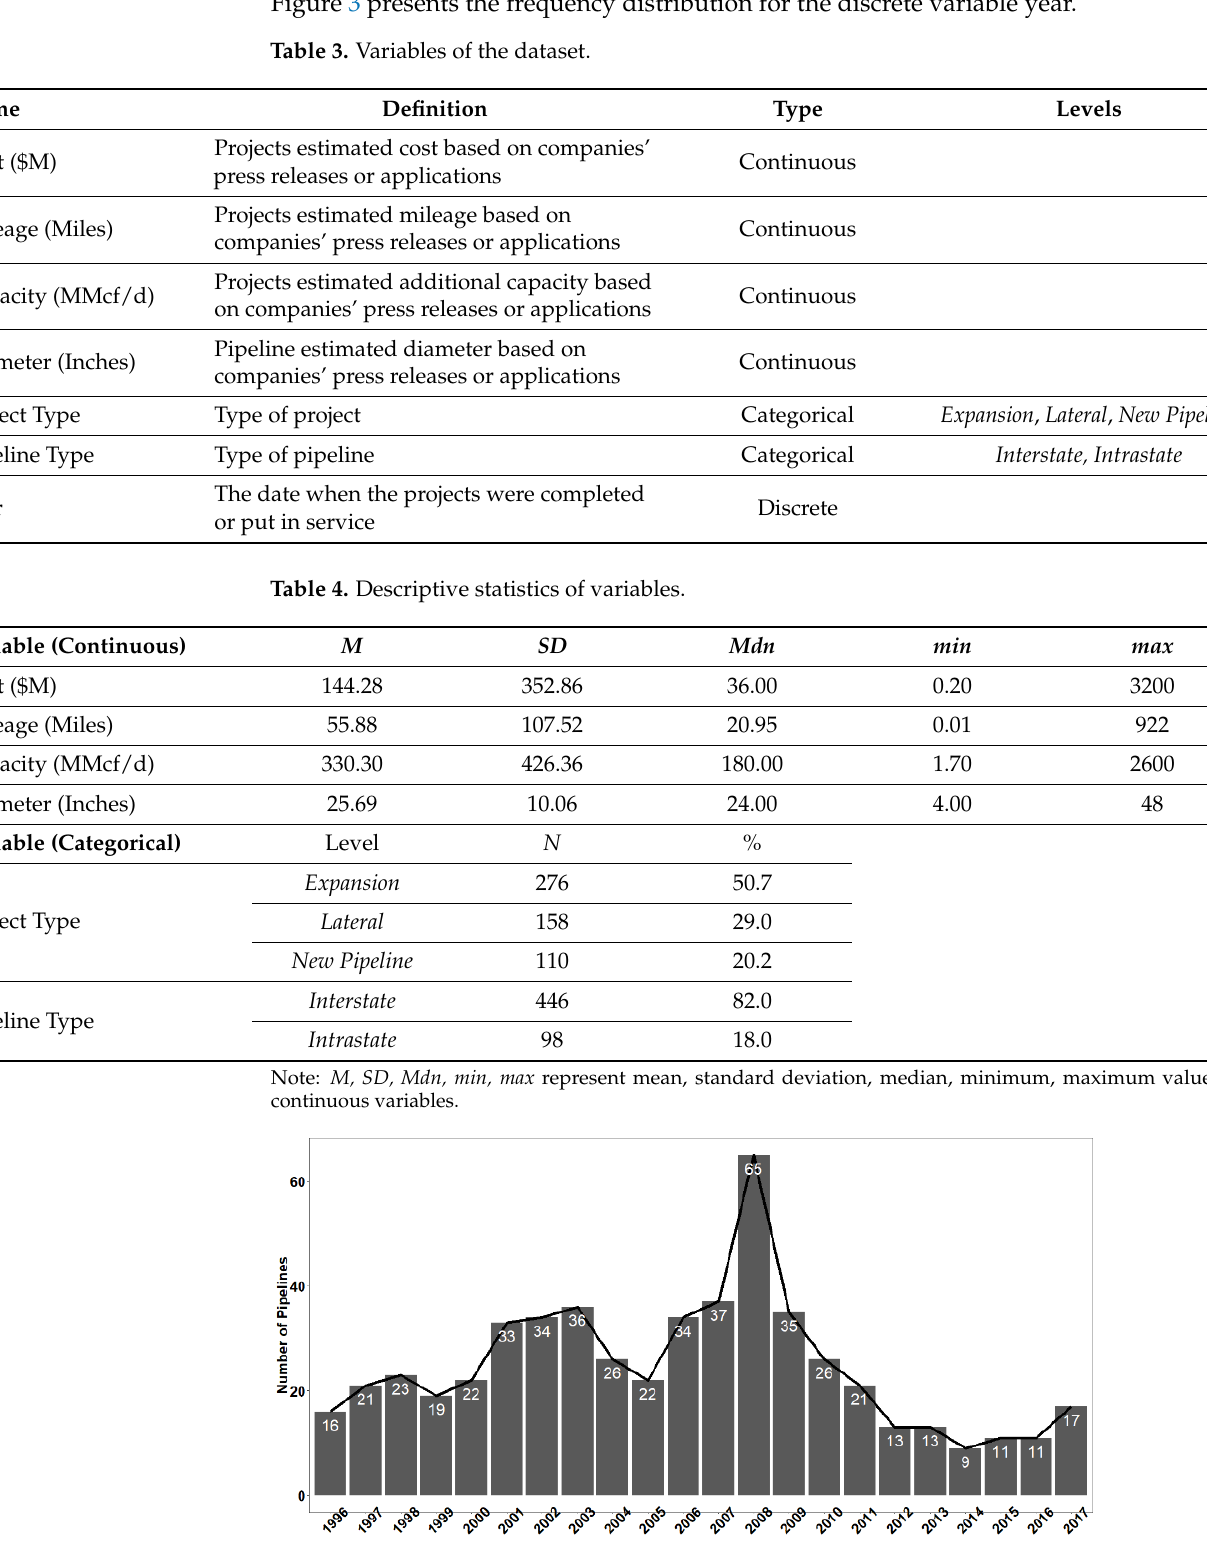
Table 3. Variables of the dataset.